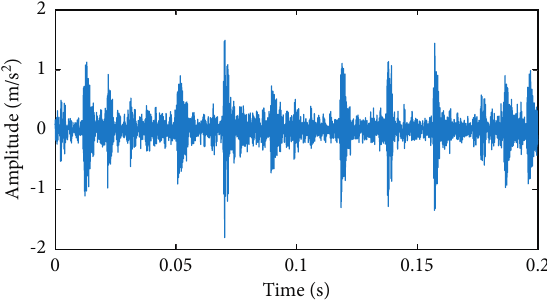
Figure 11: Time-domain waveform of weak fault vibration signal of bearing outer